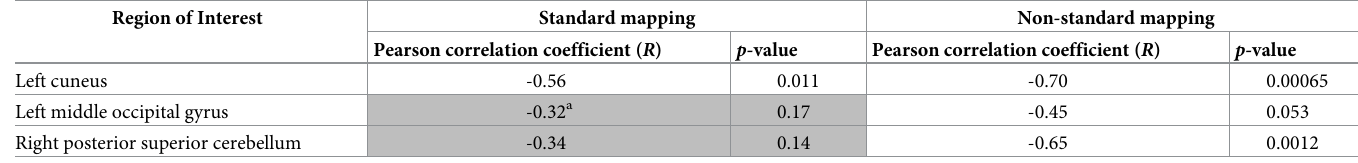
Table 2. Linear regression of mean beta weights during the instructed-delay period versus estimated time spent playing video games each week. Region of Interest Standard mapping Non-standard mapping Pearson correlation coefficient ( R ) Left cuneus Left middle occipital gyrus Right posterior superior